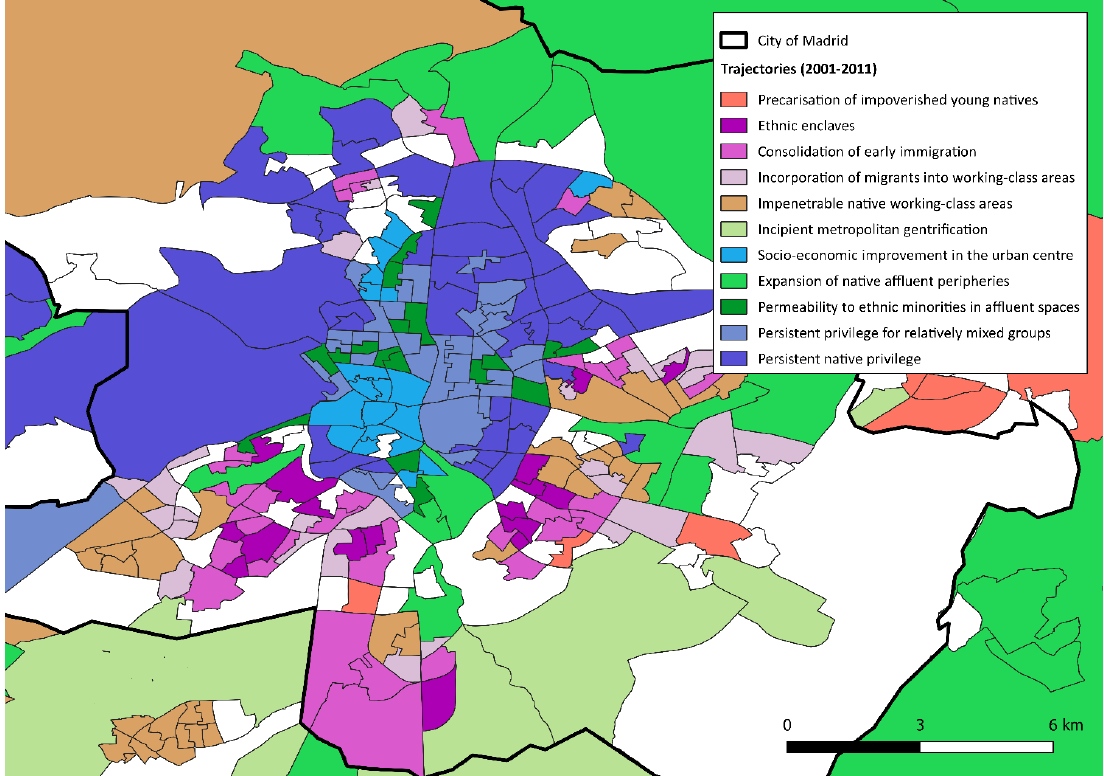
Figure 2. Main trajectories of social residential change (2001–2011) in the city of Madrid. Source: Drawn up by the authors based on the 2001 and 2011 Population and Housing censuses (INE, 2004,